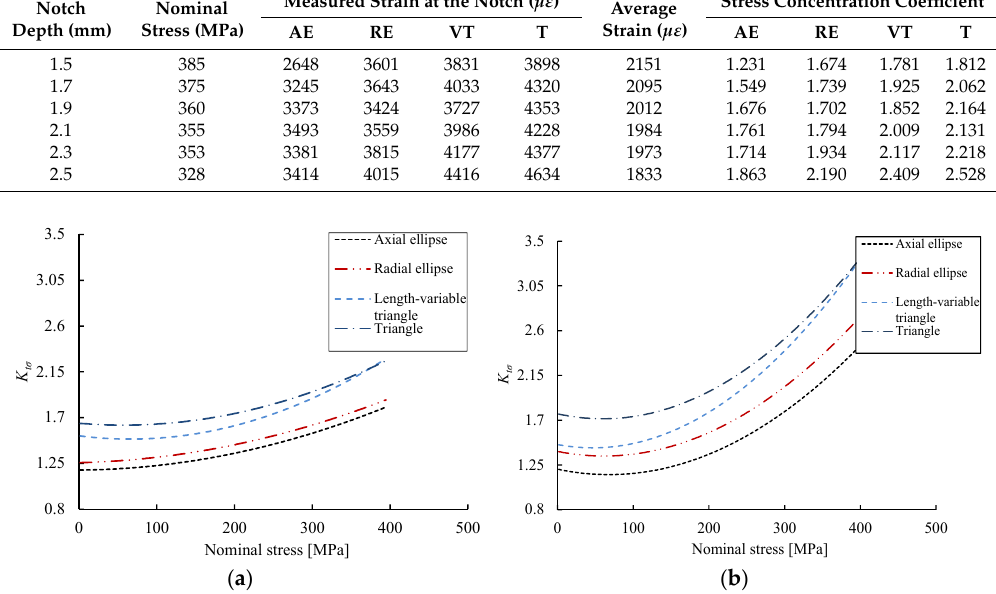
Figure 6. Evolution of stress concentration coefficient with respect to stress and notch shapes. ( a ) d = 2.1 mm; ( b ) d = 2.5 mm.